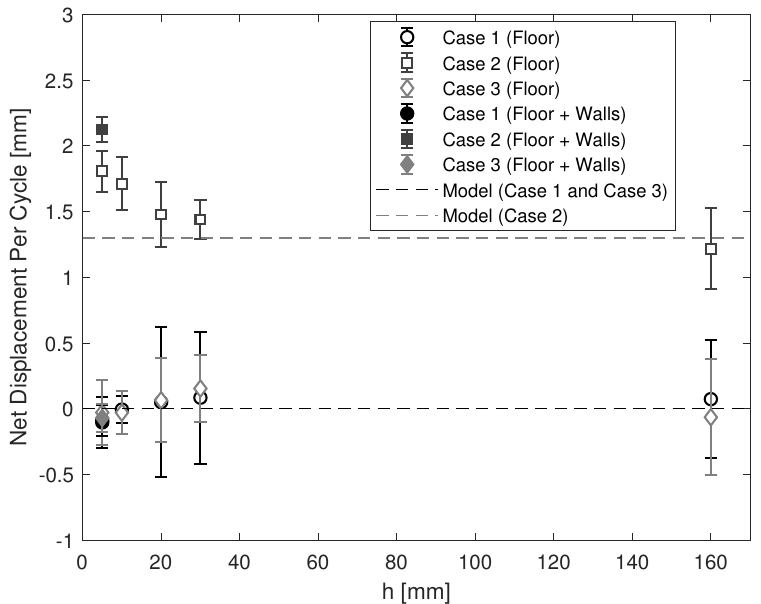
Figure 6. The net displacement per cycle at different distances h away from the floor. Markers show the net displacements per cycle, averaged over 14 cycles. Error bars show associated standard deviations. The circle, square, and diamond markers correspond to Cases 1–3, respectively. The filled markers were obtained with the arms confined by additional walls. Dashed lines show the expected net displacements per cycles according to Equation